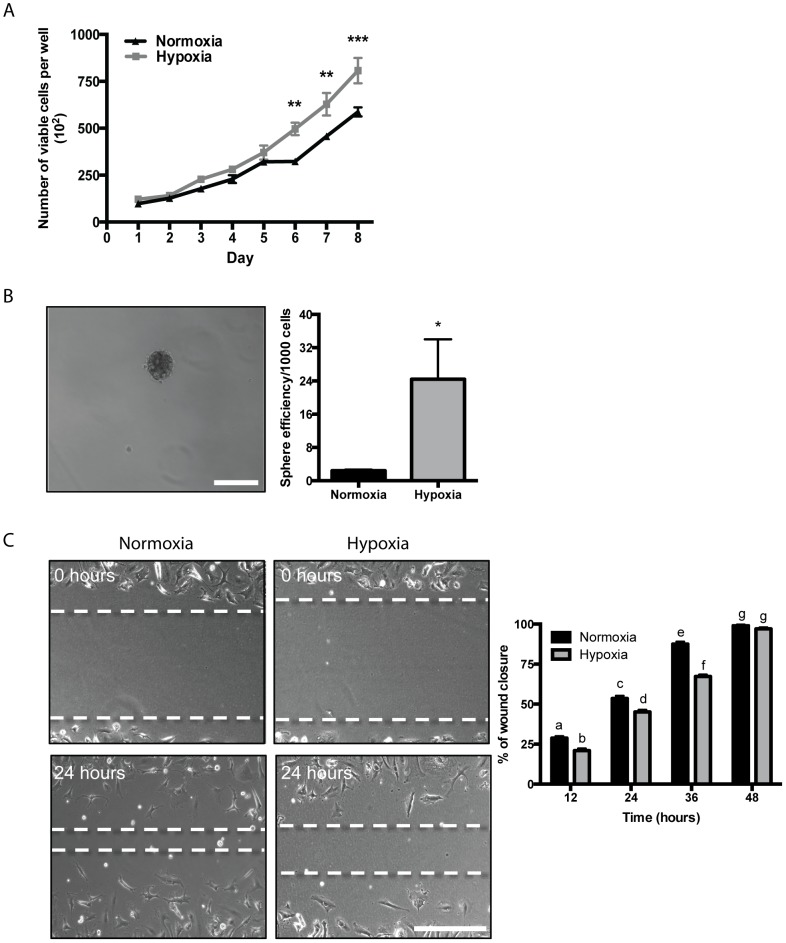
Cell growth, migration and tumour-sphere formation in U-CH1 cells in normoxic (20% O2) or hypoxic (2% O2) conditions.(A) U-CH1 cells were counted every 24 h over 8 days and demonstrate increased growth in hypoxia versus normoxia at days 6–8 (n = 3; N = 3). (B) U-CH1 cells were grown in suspension and spheres were counted after 10 days. Cells maintained under hypoxic conditions demonstrate a significant increase in sphere formation compared to cells maintained in normoxic conditions (N = 3; scale bar = 250 µm). (C) U-CH1 cells were plated and an artificial “scratch wound” was created. Cells were imaged at 12, 24, 36 and 48 h and the area of new cell migration borders was determined. Maintenance of cells in hypoxia significantly decreased cell migration at 12, 24 and 36 h compared to cells in normoxia at the same time-point (n = 4; N = 4). (2-way ANOVA with Tukey's test (A and C); Unpaired Student's t test (B); * = P≤0.05; ** = P≤0.001; *** = P≤0.0001; scale bar = 250 µm).